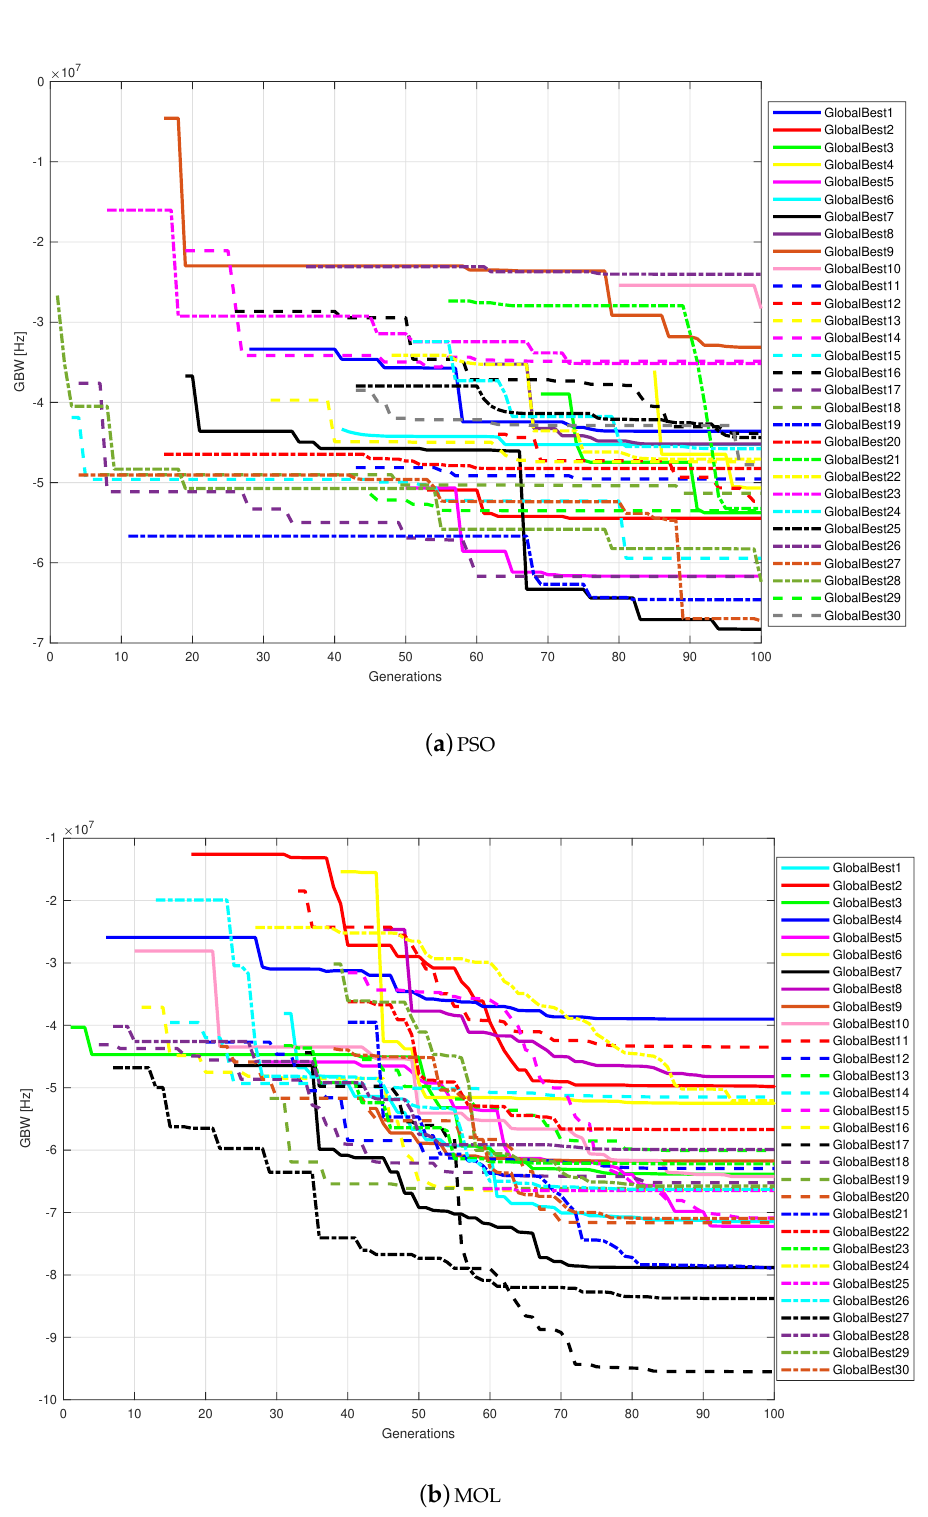
Figure 5. Global evolution of the GBW of the recycled-folded-cascode (RFC) OTA for 30 runs applying: ( a ) PSO and ( b )